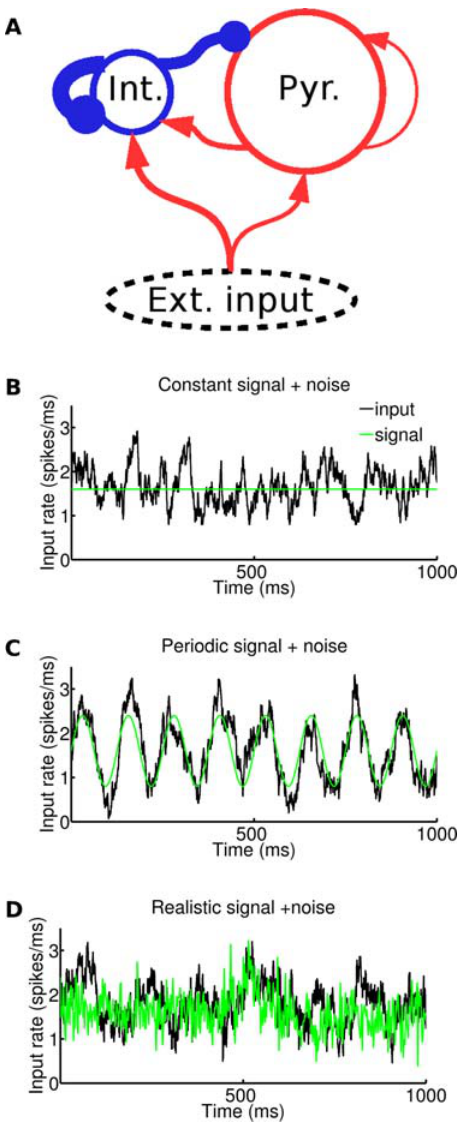
Figure 1. Network structure and inputs. (A) The network is composed of two populations (1000 interneurons and 4000 pyramidal neurons). The connectivity is random, a synapse being present between any directed pair of neurons with probability 0.2. The size of the arrows represents schematically the strength of single synapses: recurrent interactions are dominated by inhibition. In addition to recurrent interactions, both populations receive an external excitatory input. (B– D) Three types of inputs are delivered to the network. The three panels display (in black) the time-varying rate of Poissonian spike trains representing external inputs to each neuron in the network in a 1 second long interval. All inputs are a superposition of a ‘signal’ and a ‘noise’ component. The ‘signal’ is shown in green. Average value of input is 1.6 spikes/ms in all traces. The noise is modelled as an Ornstein- Uhlenbeck process (see Methods) in all cases while the three signals are different, (B) Signal: constant rate. (C) Signal: oscillatory rate (here shown with 8 Hz frequency and 0.8 spikes/ms amplitude) (D) Signal: taken from MUA recordings of LGN of anesthetized monkeys watching natural movie scenes (see